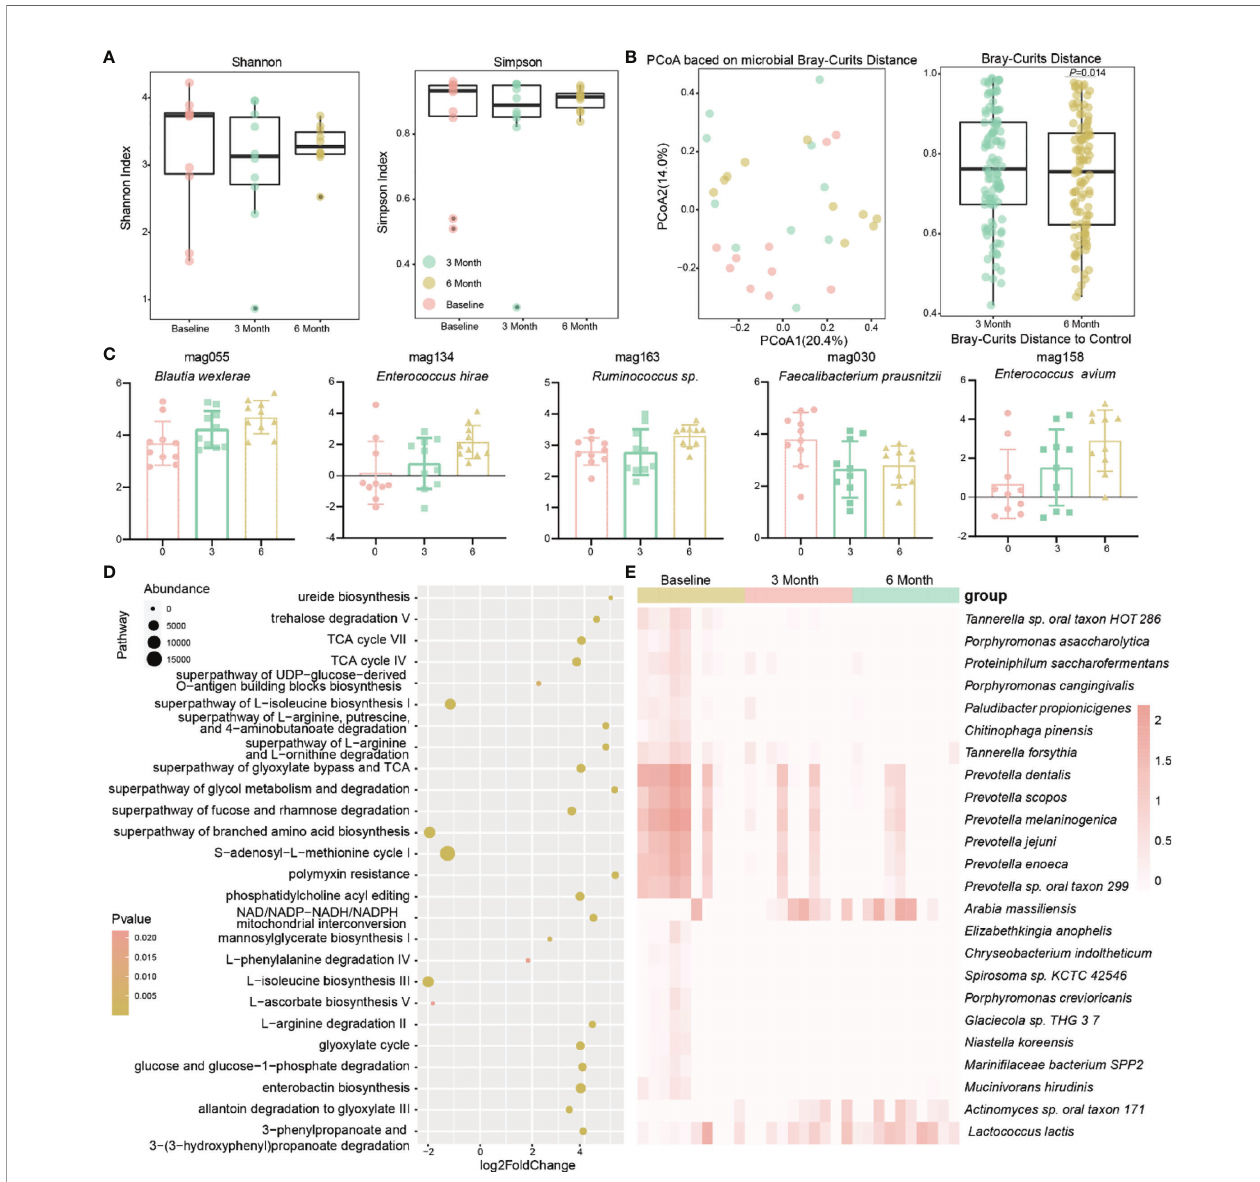
FIGURE 4 | Effect of berberine combined with methimazole on the intestinal microbiota of patients with GD. (A) The effects of berberine combined with methimazole on intestinal microbiota a diversity, including shannon and Simpson index, the same color points represent the volunteers at different time points. (B) Principal coordinates analysis (PCoA) based on Bray-Curtis distances for macrogenomic species, with points of the same color representing the volunteer at different time points. (C) MAGs with signi fi cant differences from baseline at 6 months of treatment. (D) Gut microbial metabolic pathways that differ signi fi cantly from berberine combined with methimazole treatment at baseline for 6 months. (E) Strains with signi fi cant differences from baseline at 6 months of